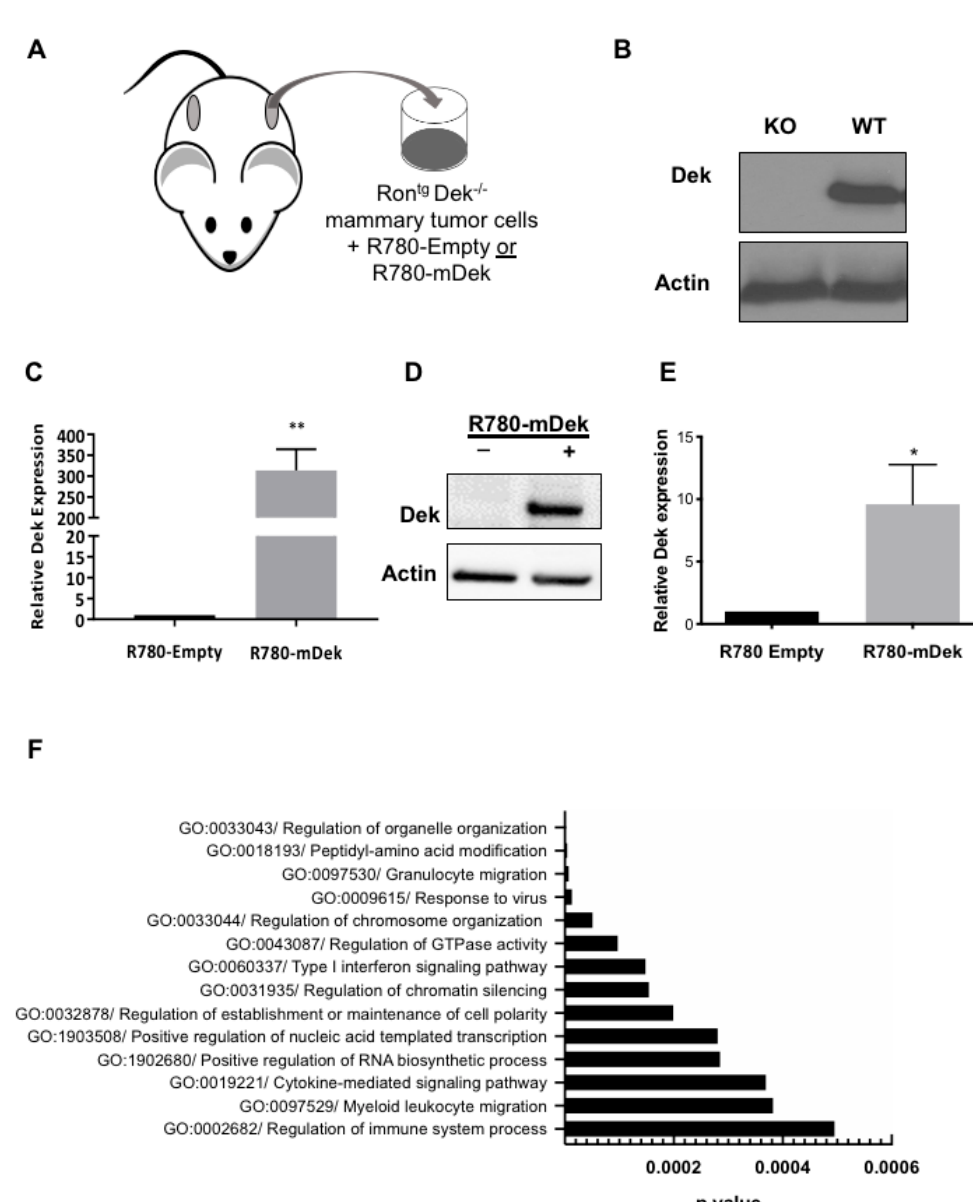
Figure 1. Transcriptomic profile of Dek expressing murine mammary cell lines reveals that genes controlling the immune response are de-regulated. ( A ) Schematic of establishing primary cells from Ron transgenic (Ron tg ) Dek knockout (Dek − / − ) mammary tumors and creating isogenic cell lines transduced with either R780-Empty or R780-mDek retroviral vectors. ( B ) Western blot of cells from Ron tg Dek knockout (KO) and Dek wild-type (WT) mammary tumors. ( C ) Quantitative RT-PCR shows increased Dek expression in the Ron tg Dek − / − cancer cell line, RD147, transduced with murine Dek over-expressing constructs (R780-mDek) compared to empty vector (R780-Empty). ( D ) Western blotting shows restoration of Dek protein levels in RD147 R780-mDek cells compared to controls. ( E ) Quantification of Dek Western blot protein levels by densitometry. For mRNA and protein data, n = 3. * indicates p -value < 0.05 and ** indicates p -value is < 0.01 using Student’s t -test. ( F ) Selected gene ontology results using ToppFun based on RNA-Sequencing results for up- and down-regulated genes in RD147 R780-mDek cells compared to R780-Empty controls.